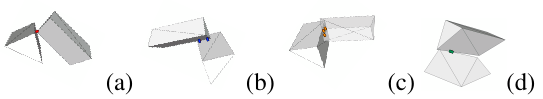
Figure 1. Di ↵ erent types of contacts between two polyhedra: (a) vertex to face; (b) edge to face; (c) face to face; (d) edge to edge; See [12, 20]